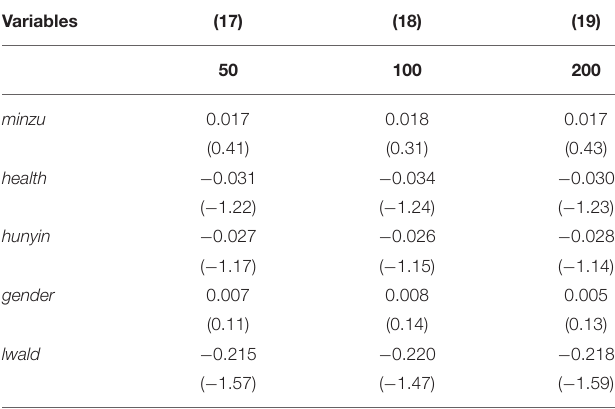
TABLE 7 | Continuity test for main control variables (based on RD regression).